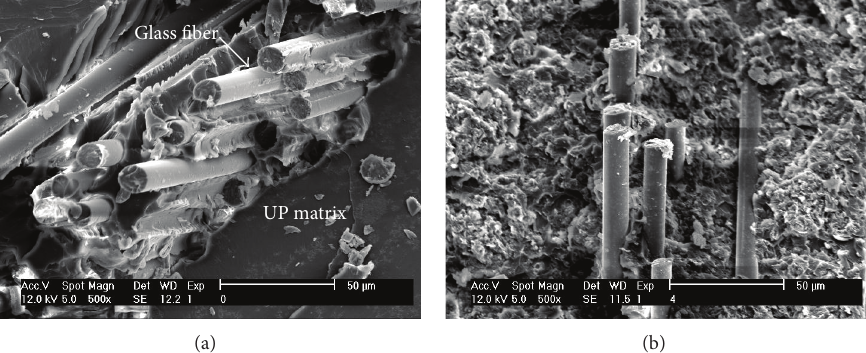
Figure 8: SEM micrographs of SEN-3PB fracture surface of (a) UP/glass fiber composites and (b) UP/glass fiber/clay composite with 4 wt% of